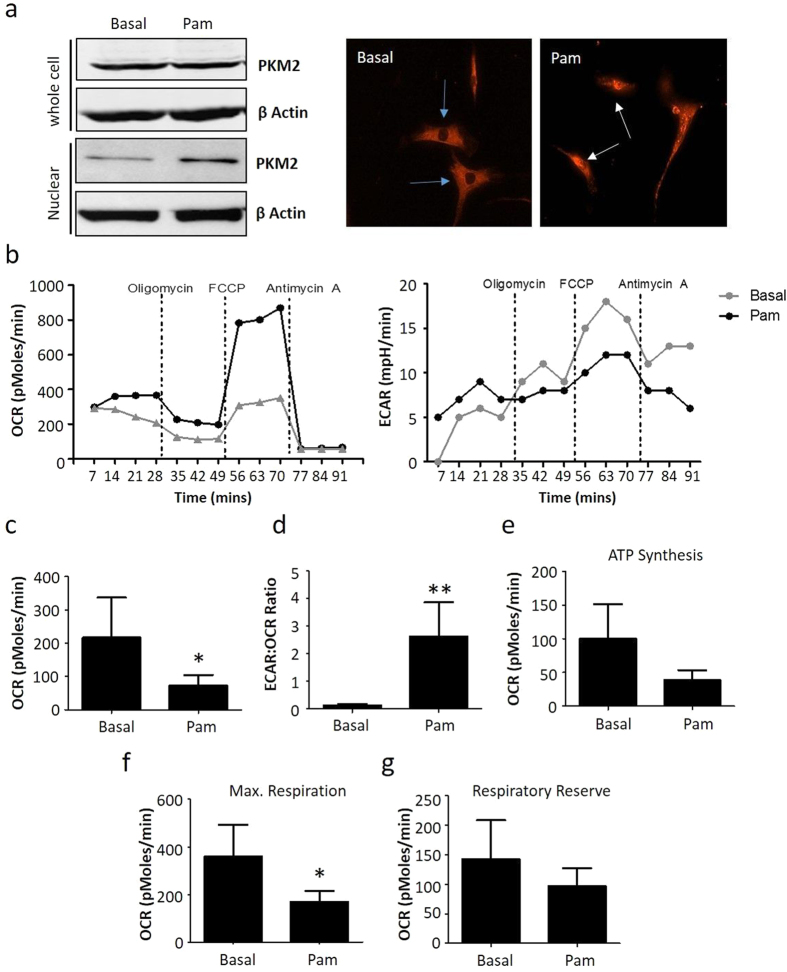
TLR2 activation induces bioenergetics changes in RASFC in vitro.(a) (i) Representative cropped western blot demonstrating expression of PKM2 in RASFC whole cell lysates and nuclear fragments in response to Pam3CSK4 (1 μg/ml) stimulation (n = 3). (ii) Representative photomicrographs demonstrating Pam3CSK4-induced nuclear localisation of PKM2 as indicated by white arrows. Blue arrows represent lack of staining in nuclei under basal conditions. Mag 20X. (n = 3) (b) Representative oxidative phosphorylation (oxygen consumption rate (OCR)) and glycolysis (extracellular acidification rate (ECAR)) Seahorse bioenergetics profiles before and after injections of oligomycin, FCCP and antimycin A for RASFC in the presence and absence of Pam3CSK4 (1 μg/ml). Bar graphs demonstrating (c), baseline respiration (OCR), (d) the ratio of glycolysis: oxidative phosphorylation (ECAR:OCR), (e) ATP synthesis, (f) maximal respiration and, (g) the respiratory reserve in RASFC in response to Pam3CSK4 (1 μg/ml) stimulation (n = 7). Data was analysed using Wilcoxin Signed Rank test and is represented as Mean ± SEM, *p < 0.05, **p < 0.01 significantly different to control.